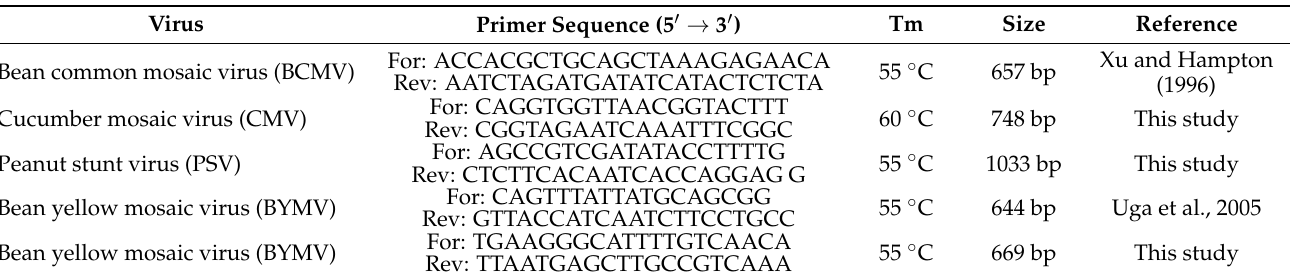
Table 4. List of primers used in conventional PCR for the detection of viruses identified by the HTS approach in Lamon bean